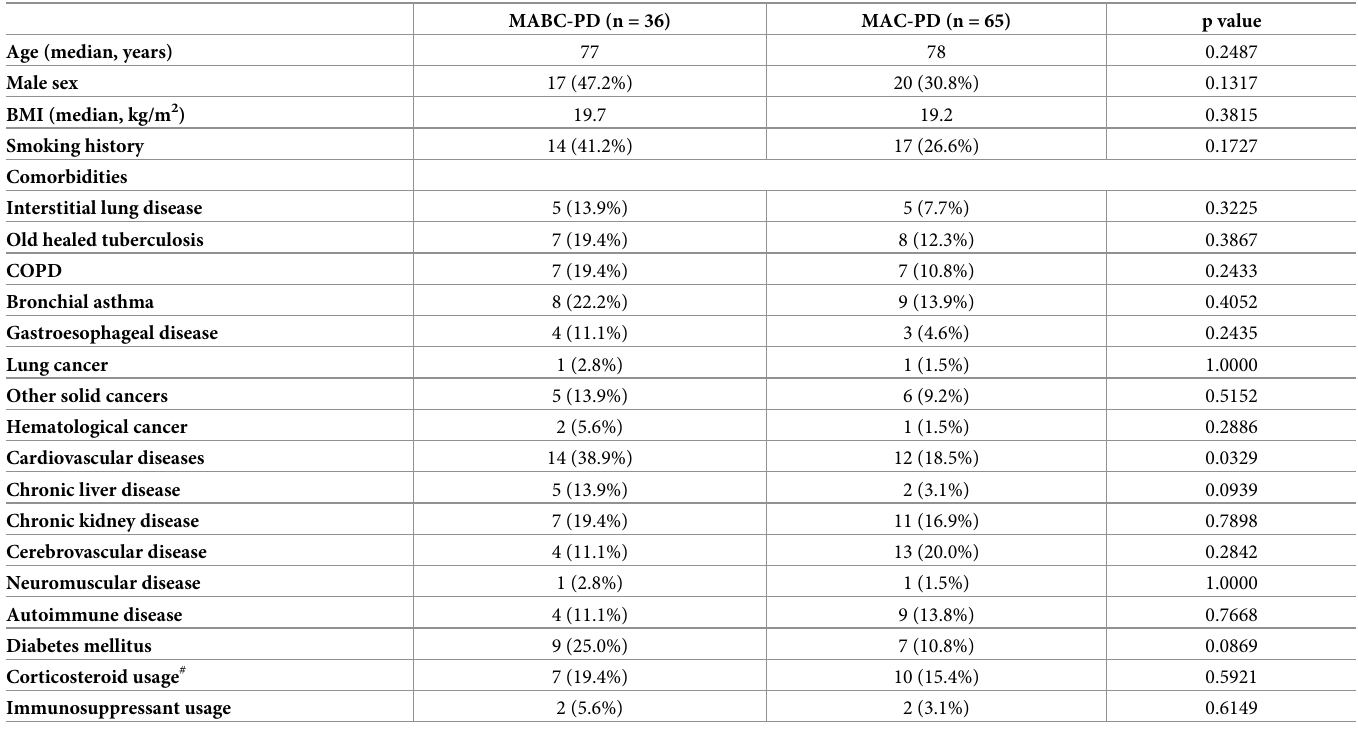
Table 1. Patients’ background characteristics.